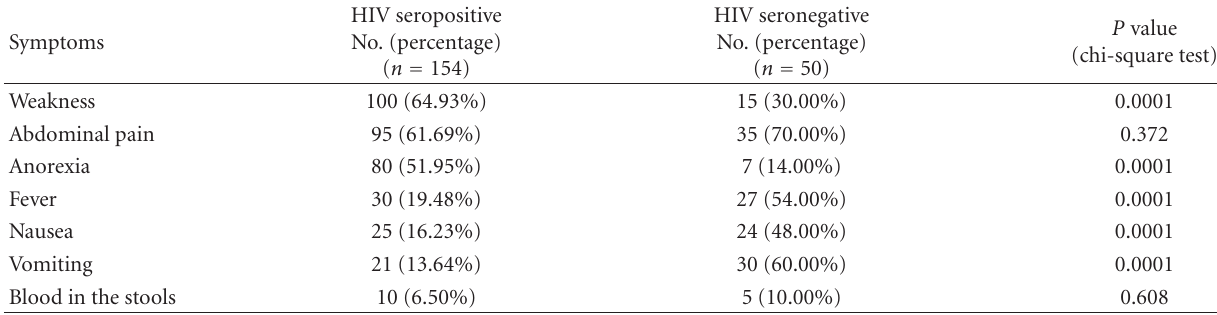
Table 1: Clinical symptoms of cases with diarrhea.